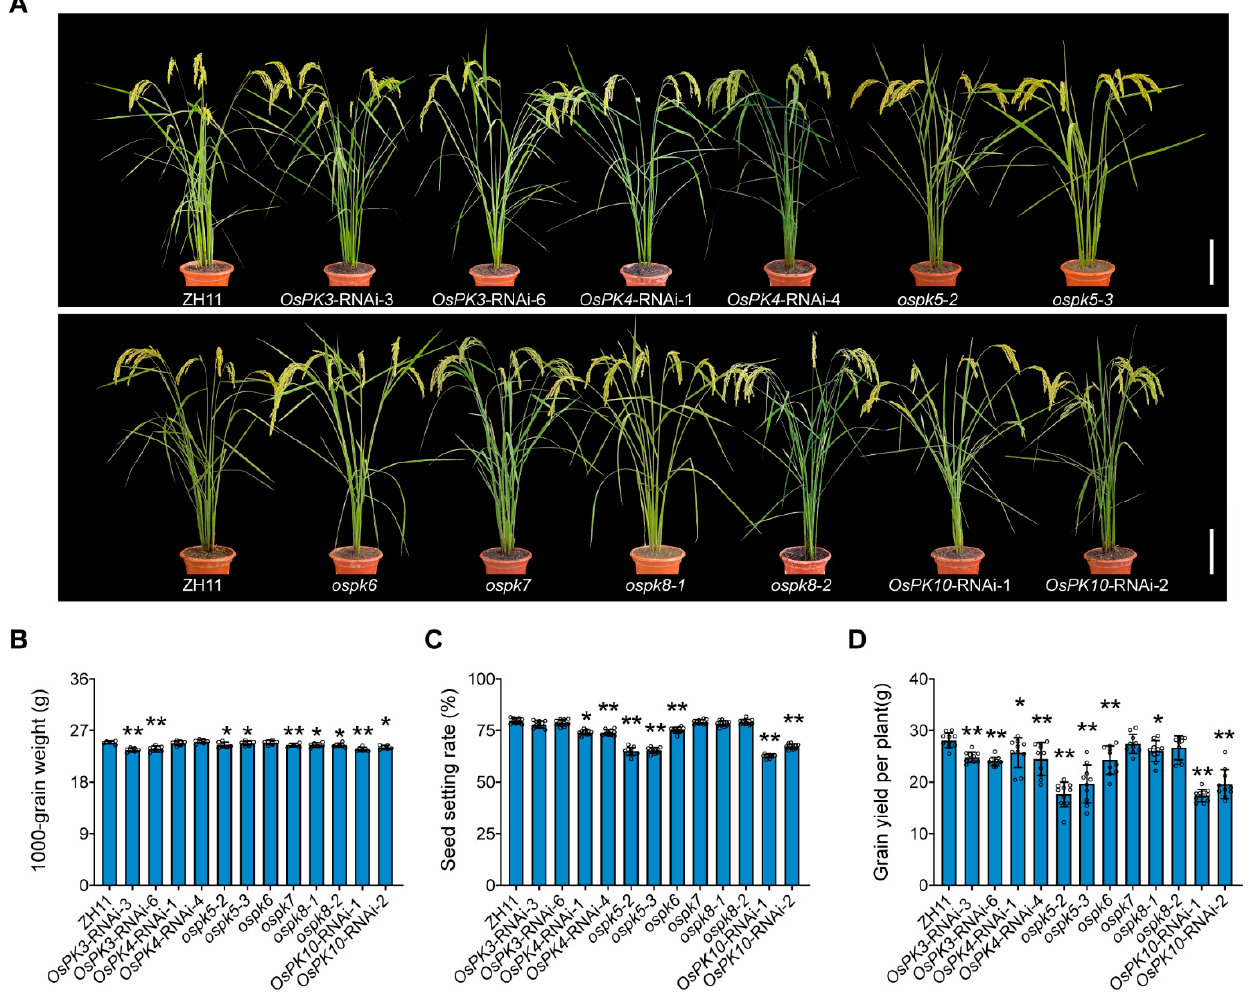
Figure 7. Yield-related traits of ZH11, CRISPR/Cas9-based mutants, and RNAi-based material of PK genes in rice. ( A ) The mature plants of ZH11, OsPK3 -RNAi-3, OsPK3 -RNAi-6, OsPK4 -RNAi-1, OsPK4 -RNAi-4, ospk5-2 , ospk5-3 , ospk6 , ospk7 , ospk8-1 , ospk8-2 , OsPK10 -RNAi-1, and OsPK10 -RNAi-2. Scale bars = 20 cm. ( B – D ) The 1000-grain weight, seed setting rate, and grain yield per plant of ZH11, the CRISPR/Cas9-based mutants, and RNAi material. n = 6 (B), n = 10 (C), n = 10 (D). Error bars indicate the means ± SDs. Asterisks indicate statistical significance between the WT and the CRISPR/Cas9-based mutants or RNAi-based materials, as determined by Student’s t -test (* p < 0.05; ** p < 0.01).